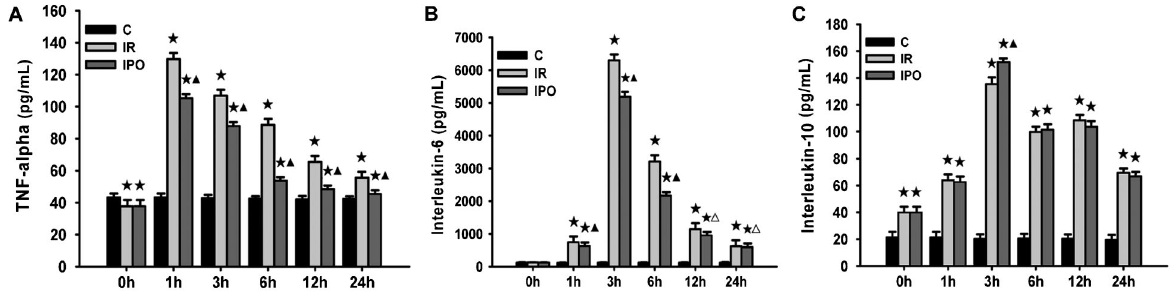
Figure 4. Inflammatory cytokine release after skeletal muscle ischemia-reperfusion (IR) injury of 3 h of ischemia and 24 h of reperfusion (n=36). A , Serum concentration of TNF- a . B , Serum concentration of IL-6. C , Serum concentration of IL-10. Data are reported as means±SD. w P , 0.01 vs sham-operated control group (C); g P , 0.05, m P , 0.01 vs IR group (one-way ANOVA).